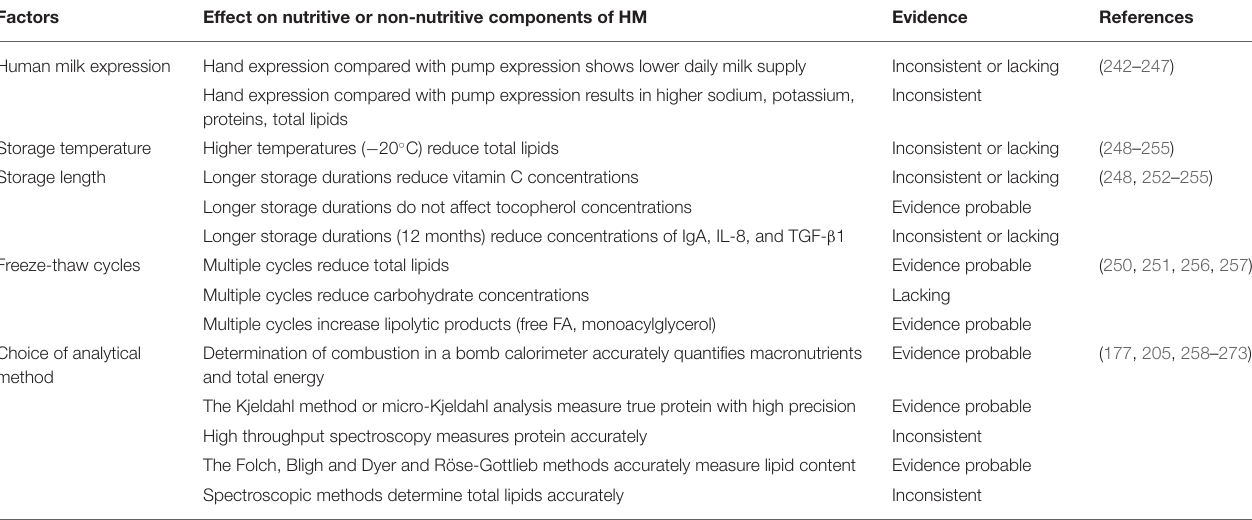
TABLE 4 | Methodological factors affecting nutritive and non-nutritive components of human milk.